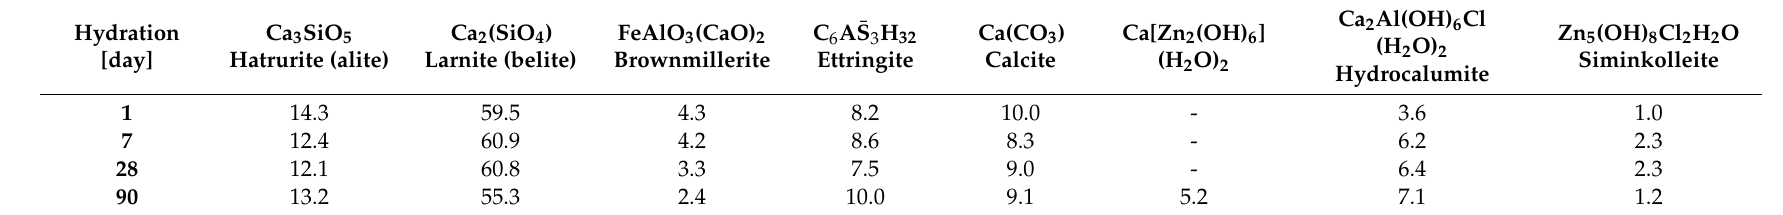
Table 5. Mineral composition of sample with ZnCl 2